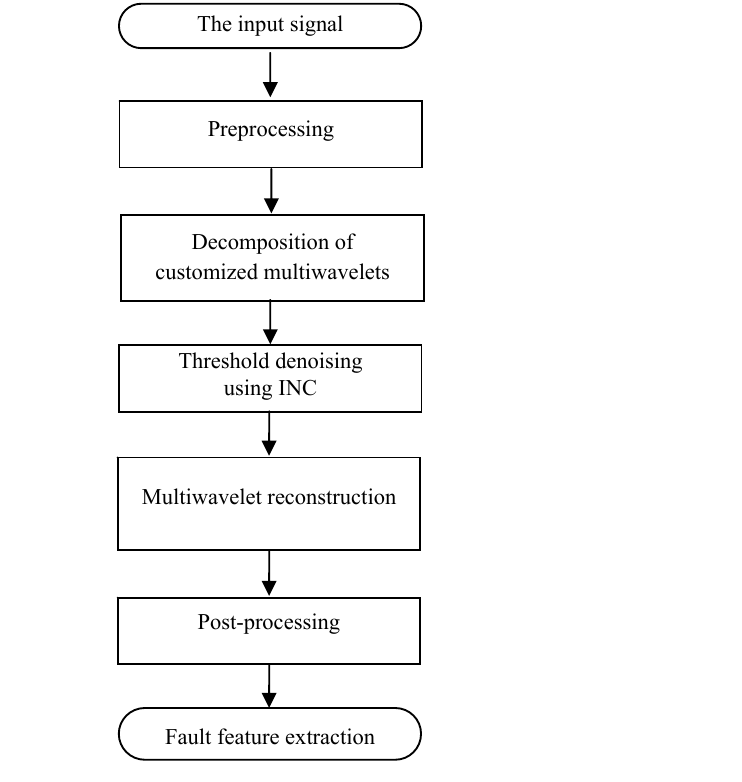
Figure 6. The flow chart of the proposed